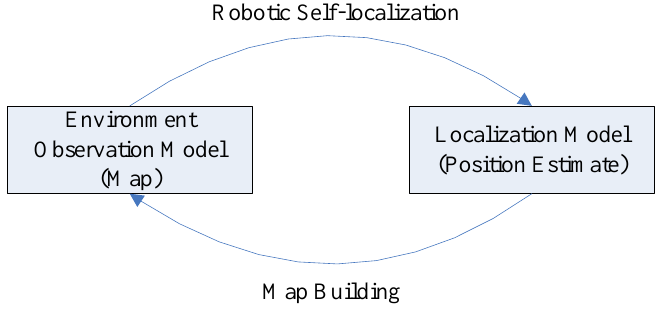
Figure 1. The problem of robotic localization and mapping.